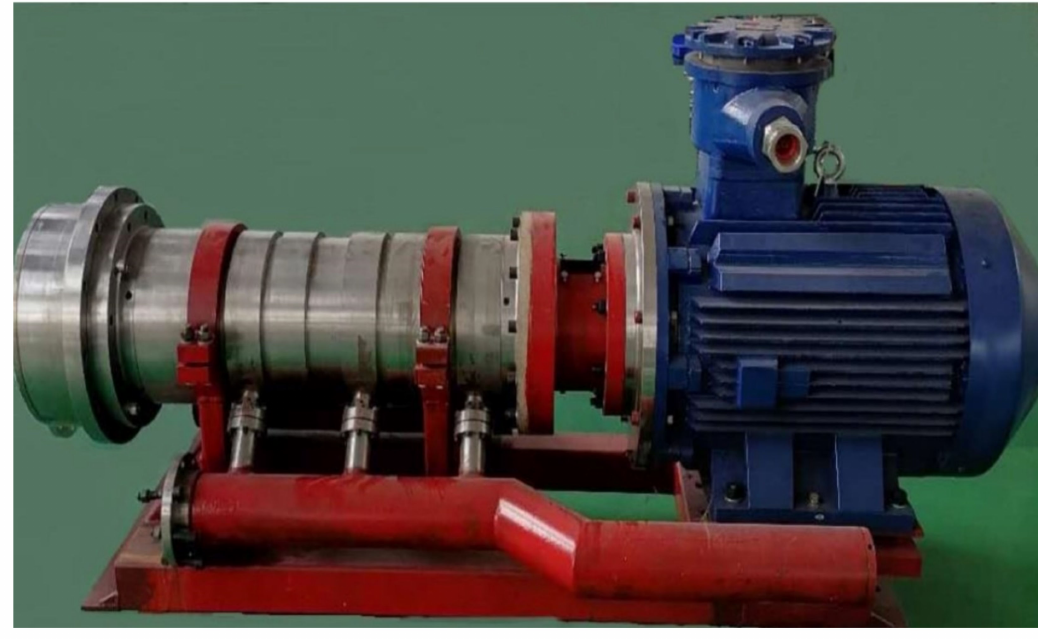
Figure 12. Compulsory stretching + super-gravity rapid dissolution device.